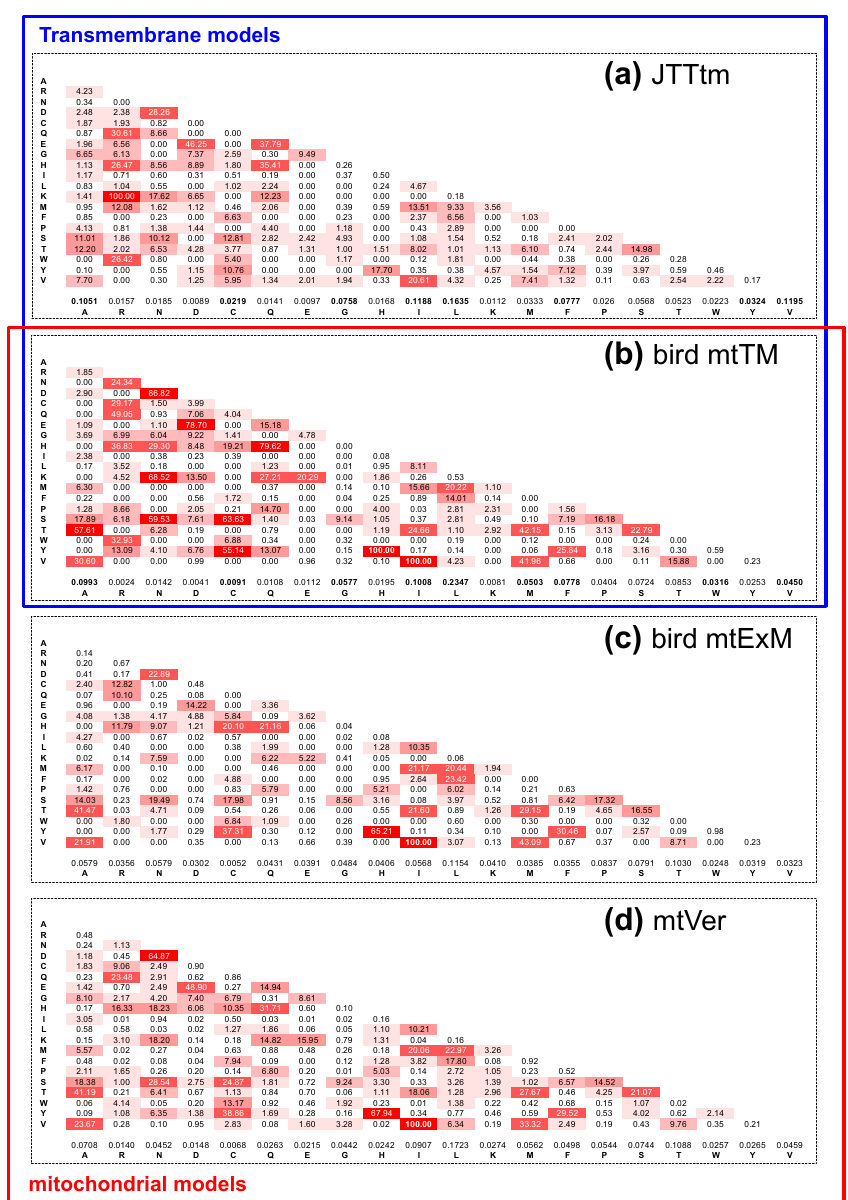
Figure 3. Models of sequence evolution for TM and ExM sites, showing amino acid frequencies (bottom) and R matrices (above). Four models of protein sequence evolution: ( a ) the JTTtm model, a general model of TM helix evolution; ( b ) bird mtTM, our new model of TM helix evolution; ( c ) bird mtExM, our new model of ExM loop evolution; and ( d ) the mtVer model [69], which was trained using all sites in mitochondrially-encoded proteins from diverse vertebrates. The TM models are inside the blue box and the mitochondrial models are inside the red box. All matrices were normalized to have a maximum exchangeability of 100. Progressively darker shades of red are used for larger relative exchangeability values. Amino acid frequency parameters highlighted in blue in the TM models have values that are higher than the bird ExM amino acid frequency. These R matrices available from https://github.com/ebraun68/protmodels (accessed on 26 September 2021) and in Supplementary File S2.